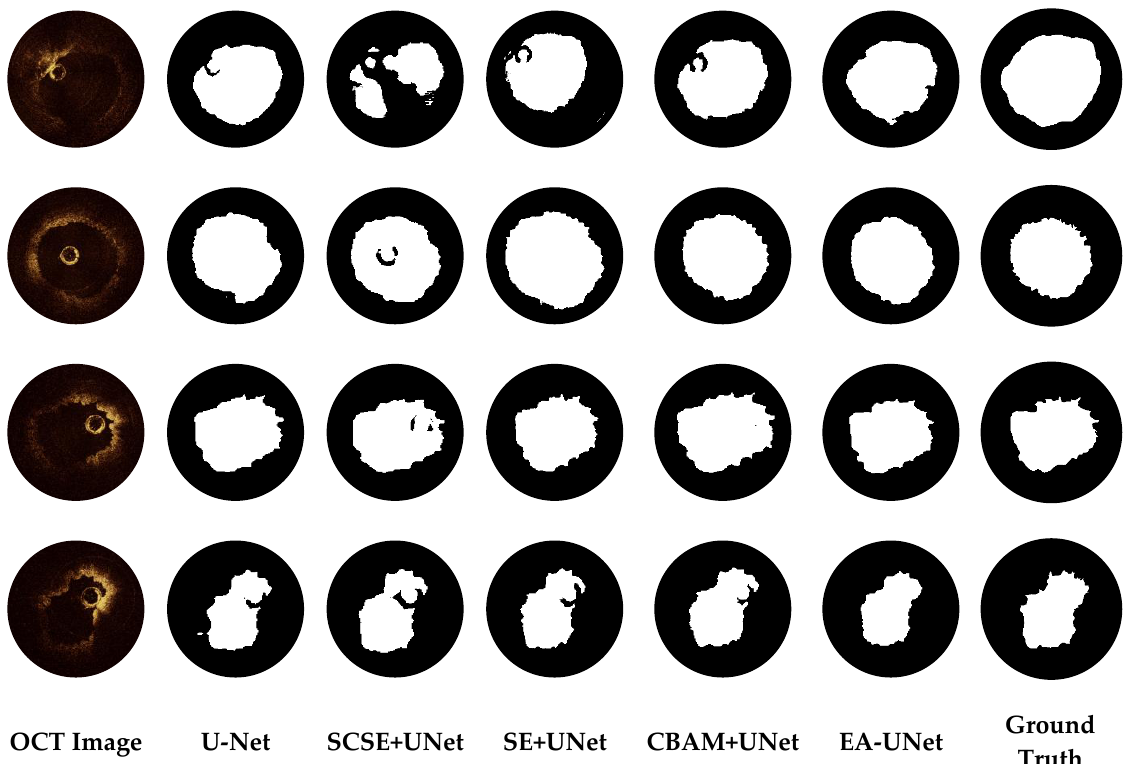
Figure 5. Comparison of segmentation effects of different attention modules.